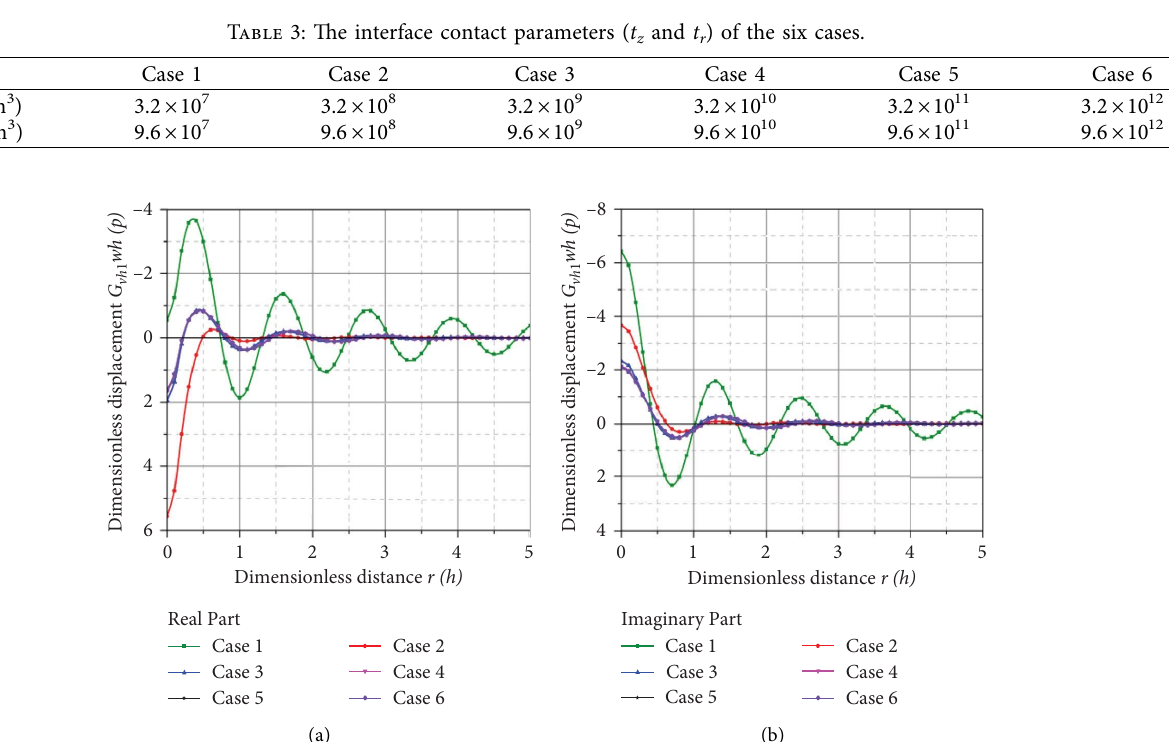
Figure 8: Te vertical displacement of the medium versus the dimensionless distance for the diferent cases at a fxed dimensionless frequency of 2 ( ω 0 � 2) and a depth of zero ( z � 0m): (a) the variation of the real part; (b) the variation of the imaginary